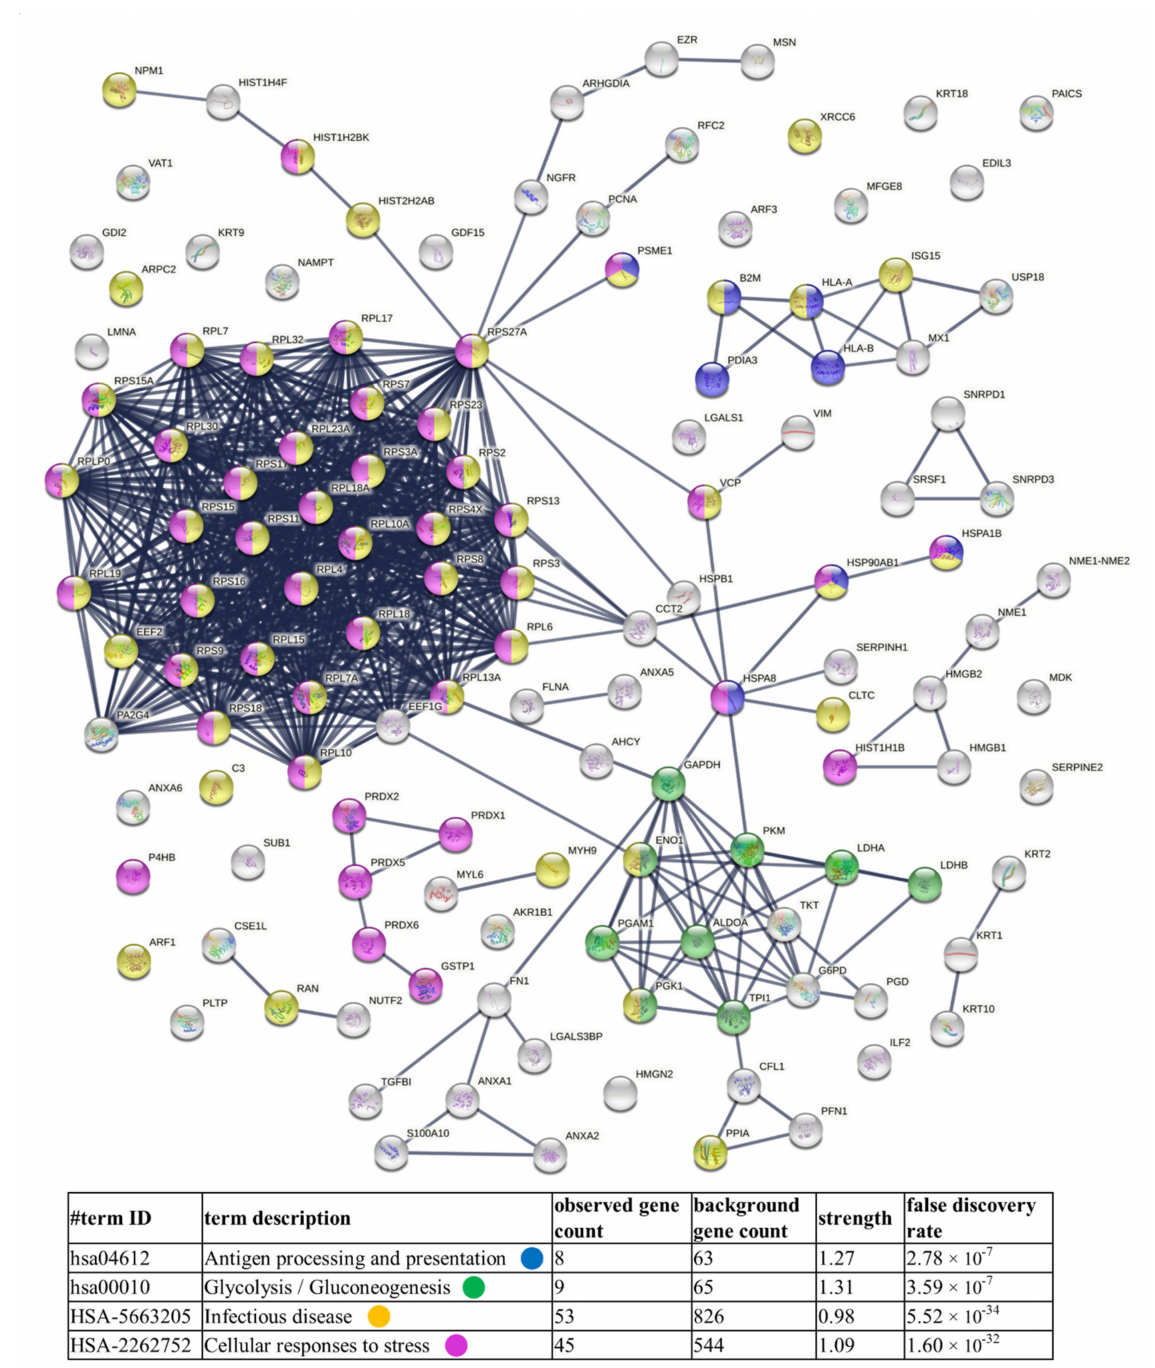
Figure 8. Diagram of functional protein association networks prepared with the use of STRING v. 11.0 software for 5% of the most abundant proteins identified in 8305C-derived ectosomes (i.e., 127 proteins). The selected strongly represented pathways are presented as an interactome. Complete results are provided in Supplementary Data